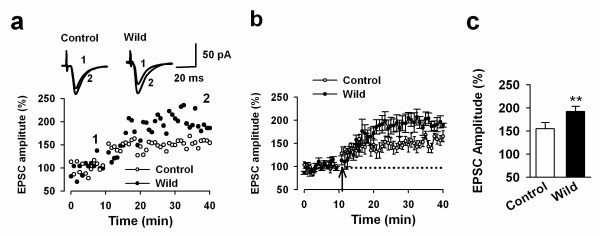
Enhanced LTP induced by the pairing protocol in the ACC of wild mice. a: Examples of synaptic potentiation of EPSCs in the layer II/III pyramidal cells of a wild mouse (filled circles) as compared with that in a laboratory (control) mouse (open circles); Inset: sample traces show averages of EPSCs 5 min before (1) and 30 min after (2) the paired training; b: Summarized data for LTP in slices of wild mice (filled circles) and control mice (open circles); c: Summarized data of EPSC amplitude 30 min after LTP induction in slices of control and wild mice. **P < 0.01, compared with laboratory group. Data are presented as mean ± s.e.m.